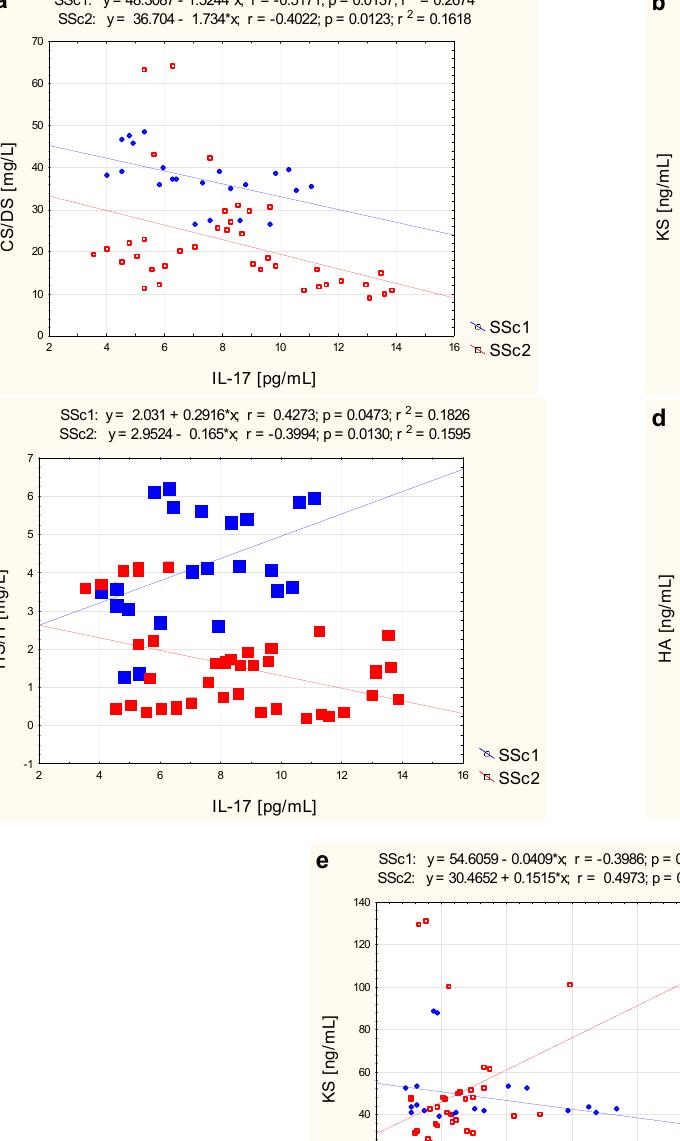
7 of 15 Table 3. Correlation analysis between plasma CS/DS, HS/H, HA, KS and IL-17 and IL-18 as well as urinary (u) CS/DS, HS/H, HA and uACR in patients with systemic sclerosis (Pearson’s correlation coefficients, r).